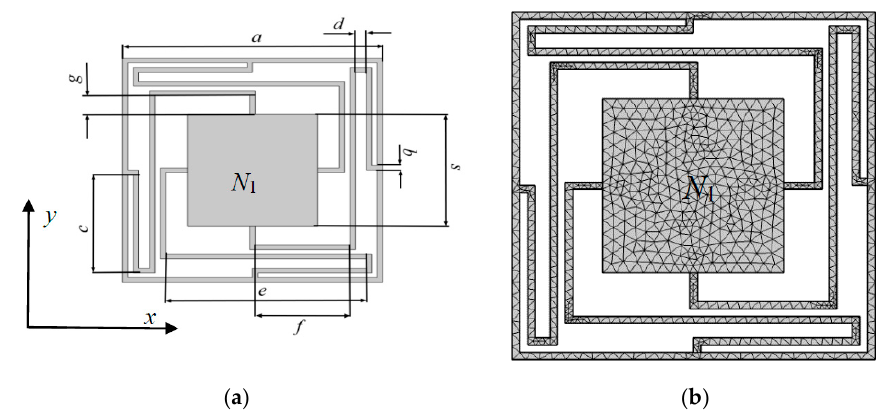
Figure 1. ( a ) The sketch of the phononic crystal (PC) structure; ( b ) The finite element method (FEM) meshes of the proposed PC structure.